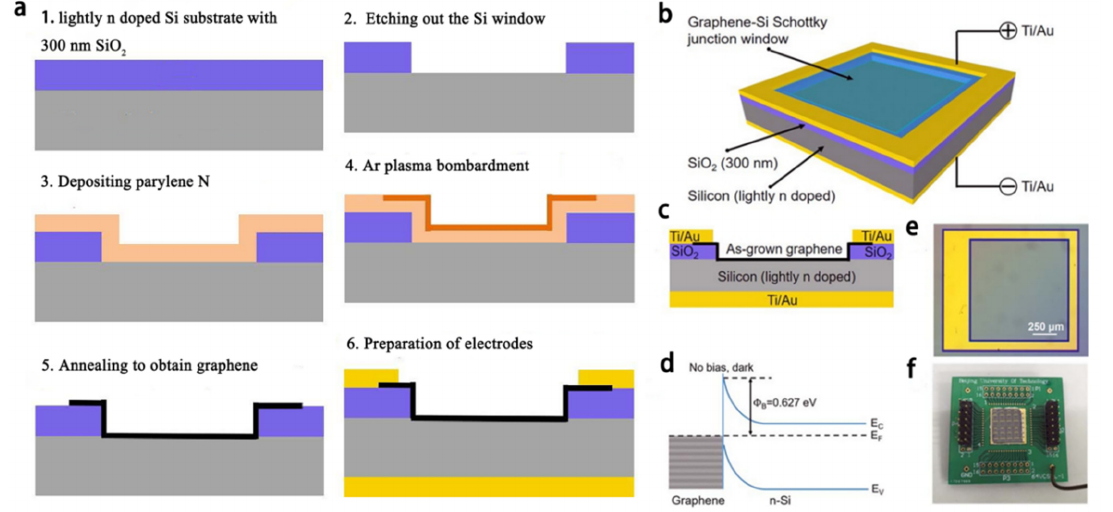
Figure 12. ( a ) Construction process of in-situ grown graphene-silicon Schottky junction photoelectric sensor. ( b ) Schematic diagram of the structure of the device. ( c ) Schematic diagram of cross-section structure of the device. ( d ) Schematic diagram of energy band structure of Schottky junction. ( e ) Optical microscope image of the device. ( f ) Physical drawing of the device.